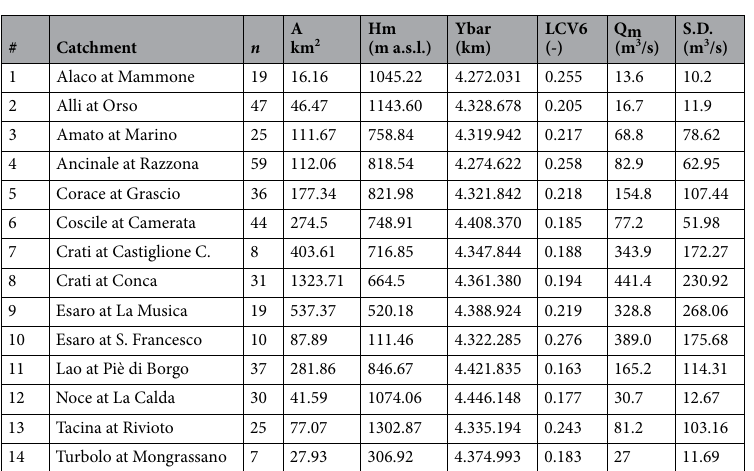
Table 1. Geomorphoclimatic characteristics of the investigated catchments: A is the catchment area, n is the record length in years; Hm is the mean catchment elevation; Ybar is the latitude of the center of the basin; LCV6 is the LCV of annual maxima of rainfall heights for a duration of six hours; Qm is the mean value of the annual streamflow maxima; S.D. is the standard deviation of annual maxima time